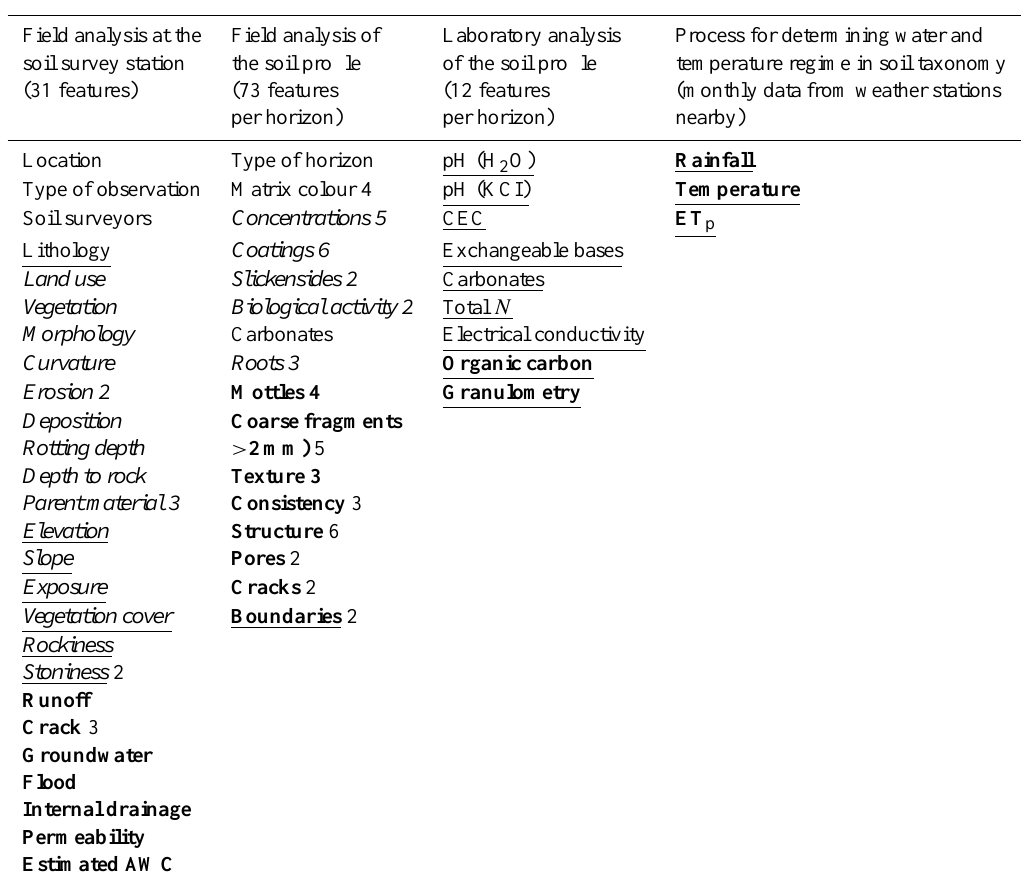
Table 2. Example of soil features typically found in a pedological description. Numbers indicate the amount of sub-characters supplying each